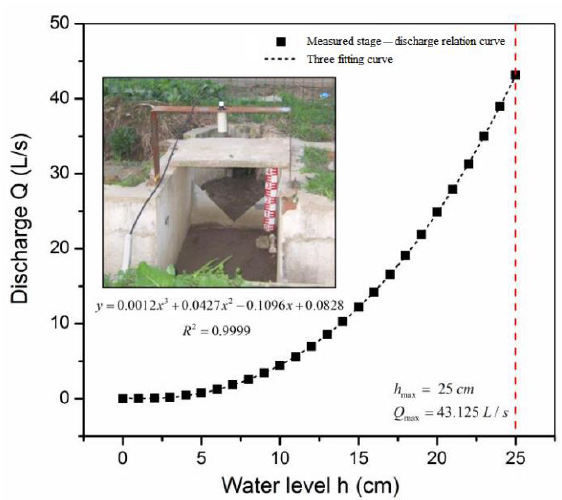
Figure 2. ( a ) Observation instrument in the core test area of BTQ site, ( b ) the soil water profile meas- urement sensors, and ( c ) the V-notch weir at the outlet.